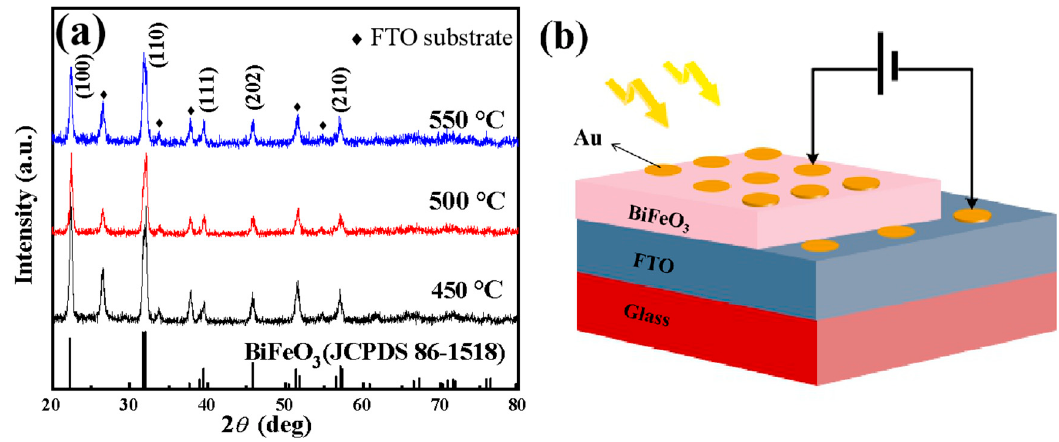
Figure 1. ( a ) X-ray diffractometry (XRD) patterns of BiFeO 3 (BFO) thin films annealed at 450, 500